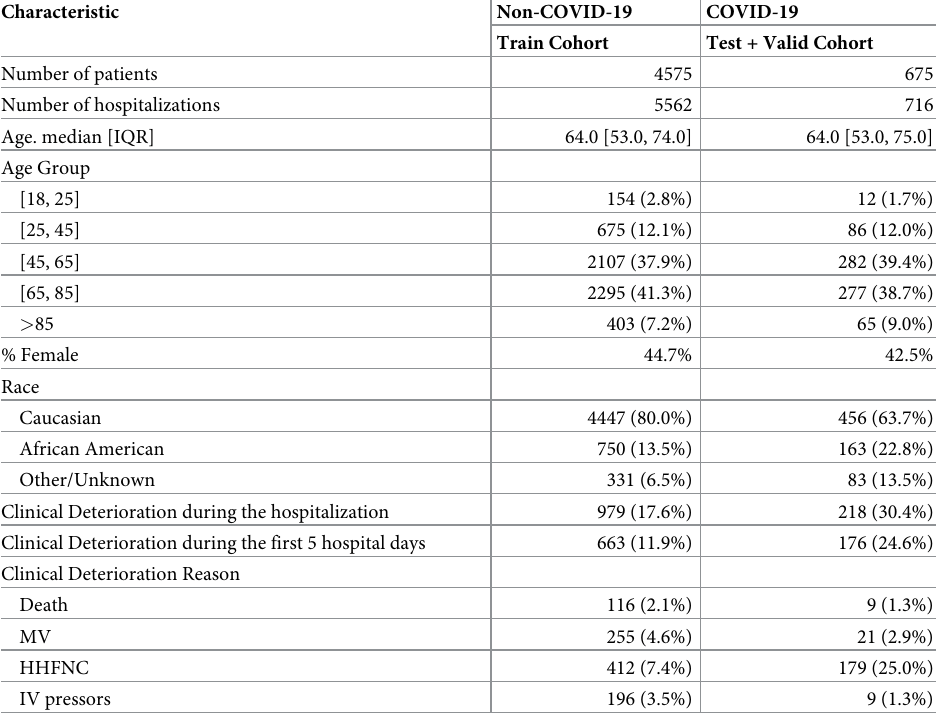
Table 1. Demographic and clinical characteristics of the patients